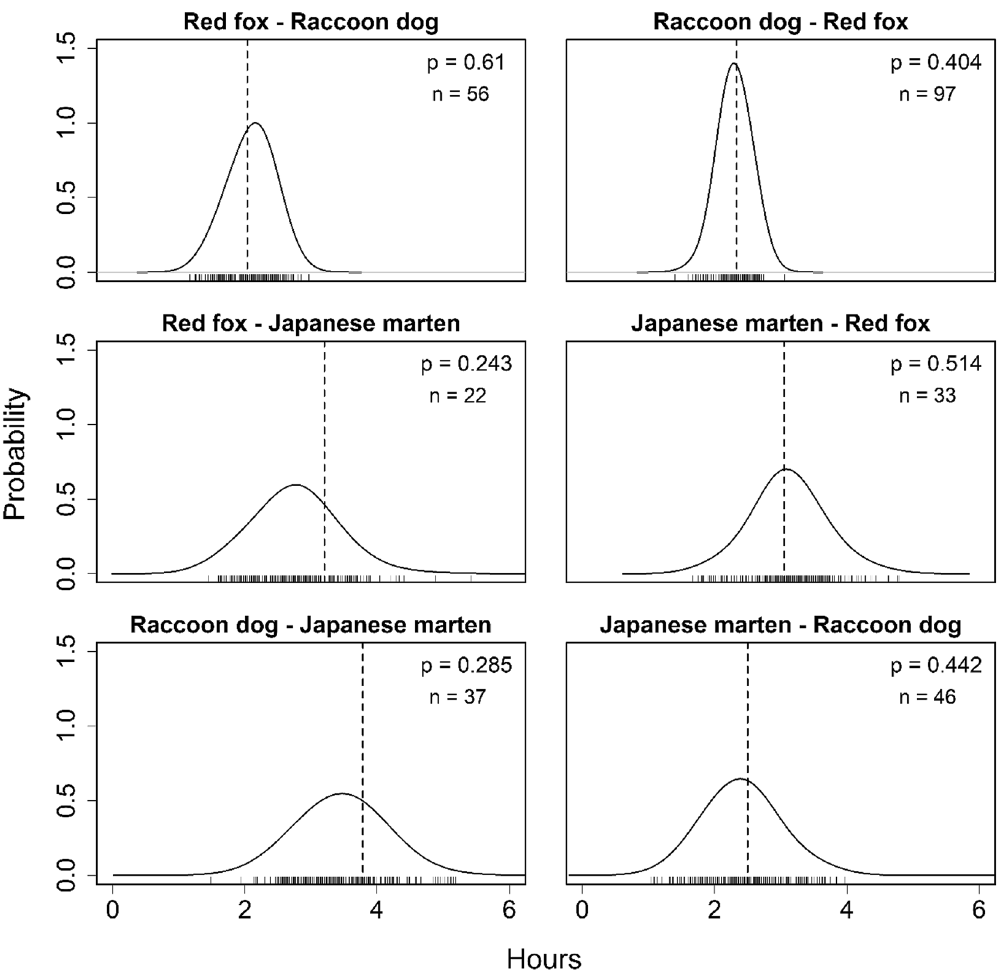
Figure 5. Results of the time-to-encounter analysis using the 15-MRPP. Red fox-raccoon dog represents that raccoon dogs was detected after red foxes, for example. The dashed vertical lines represent the observed median time-to-encounter between two species. The rug plot represents the 1,000 medians of the random permutations and the curve represents the distribution estimated from them; n represents the number of the observed time- to-encounter. The p -values indicate the proportion of times the observed median was larger than the medians of the random permutations.